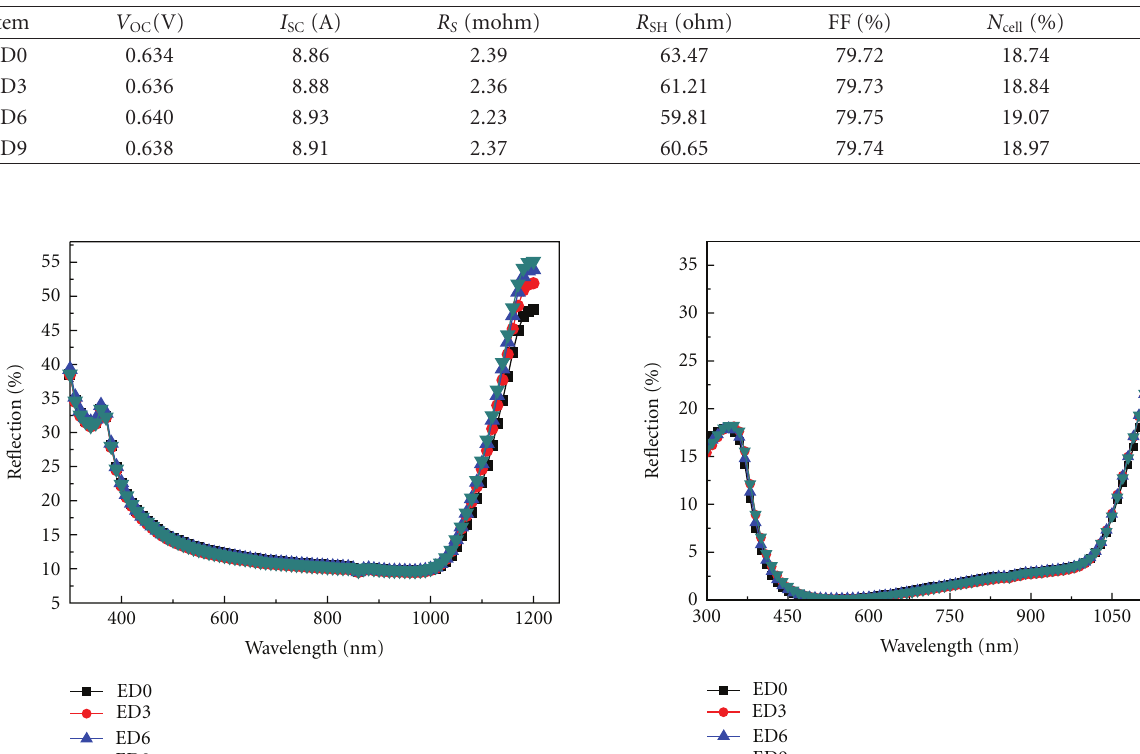
Table 5: The devices characteristic of di ff erent etching depths.